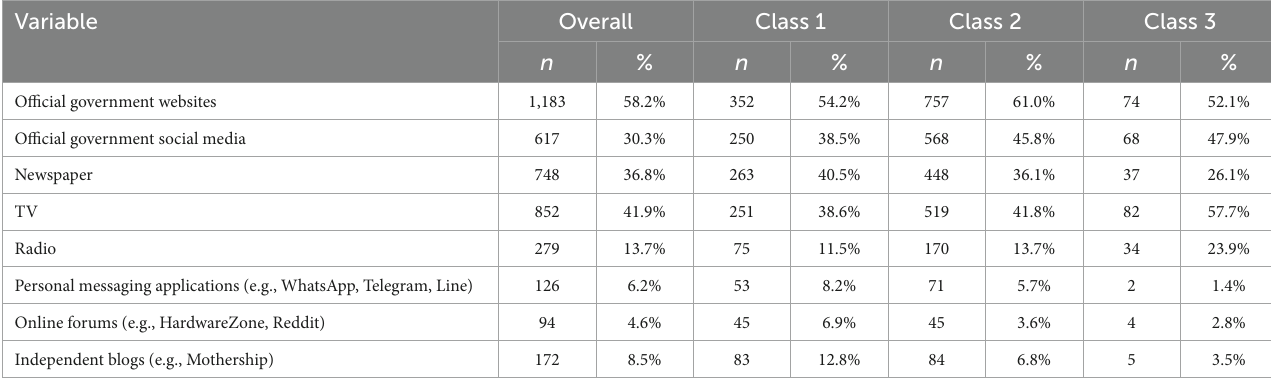
TABLE 5 Differences in platform